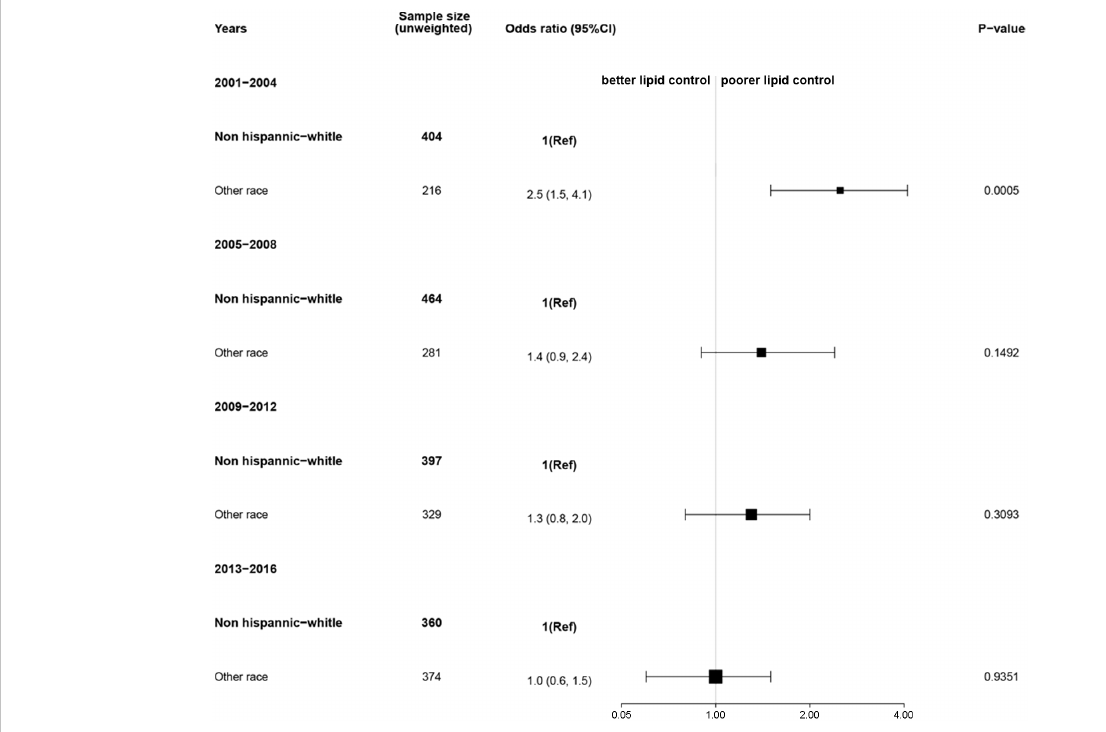
FIGURE 4 Association of race with lipid control among survivors of stroke and/or myocardial infarction. Nationally representative estimates of the survivors of stroke and/or myocardial infarction aged ≥ 20 years in NHANES from 2001 to 2016 (n=3,245, representing a weighted total population of 97,726,894). Poor or good lipid control was de fi ned as total cholesterol > 200 mg/dL or not, respectively. The reference group was non-Hispanic White race. An odds ratio > 1 indicates a higher rate of poor lipid